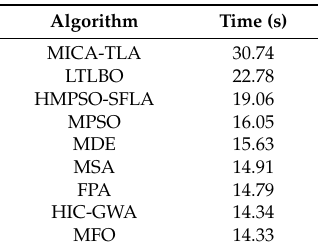
Table 20. Case 2 simulation